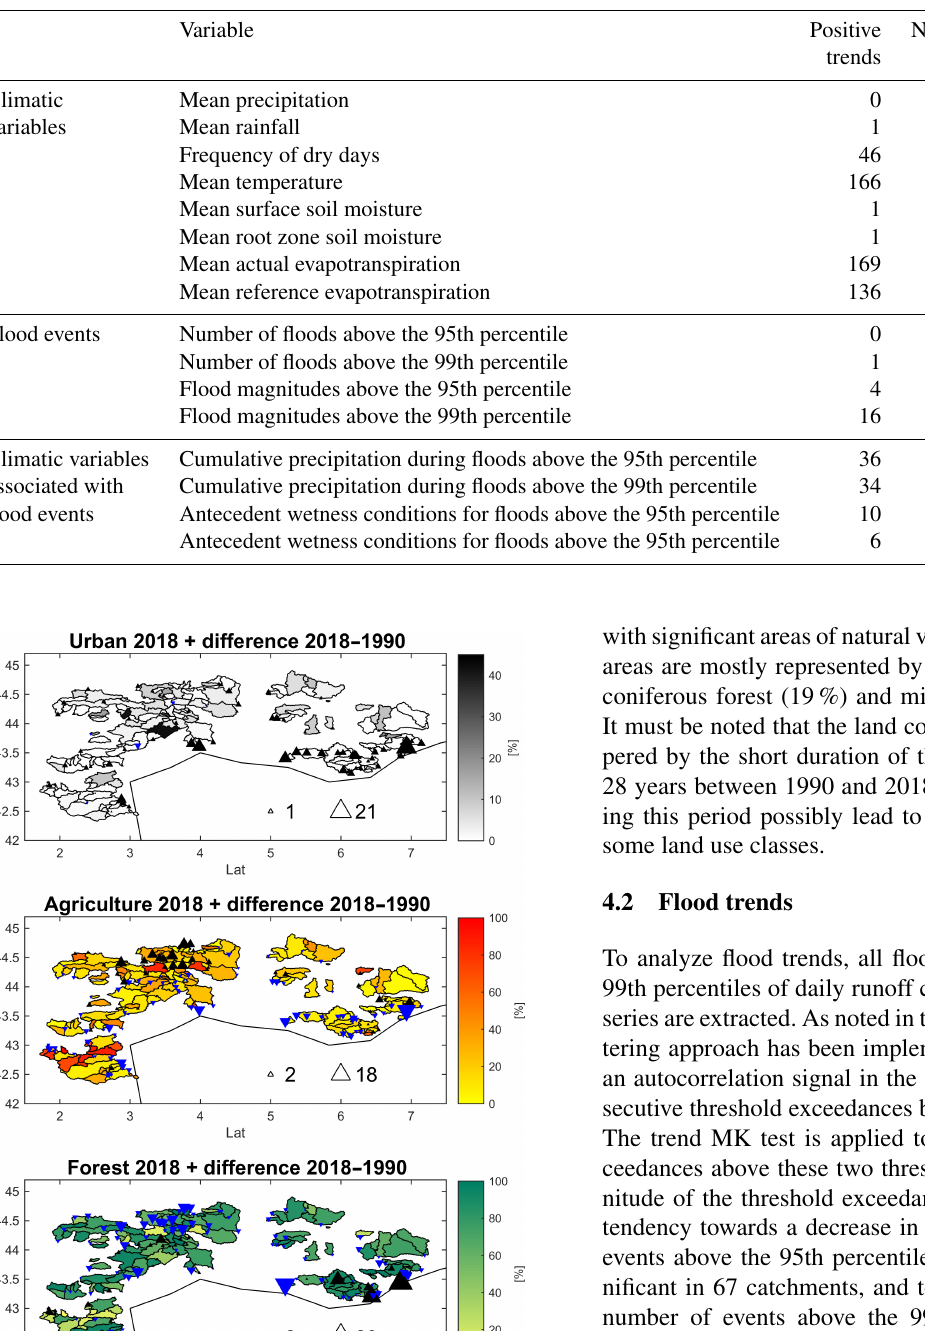
Table 1. Summary of the trend detection on different variables: number of positive and negative trends significant at the 10% level and regional significance.